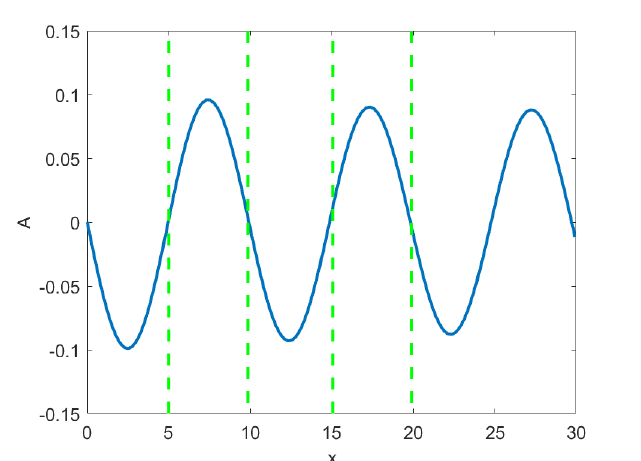
Figure 5. Numerical Simulation of the Wave Propagation Phenomenon with